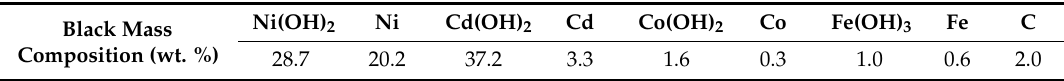
Table 2. Composition of industrial black mass coming from spent Ni/Cd batteries